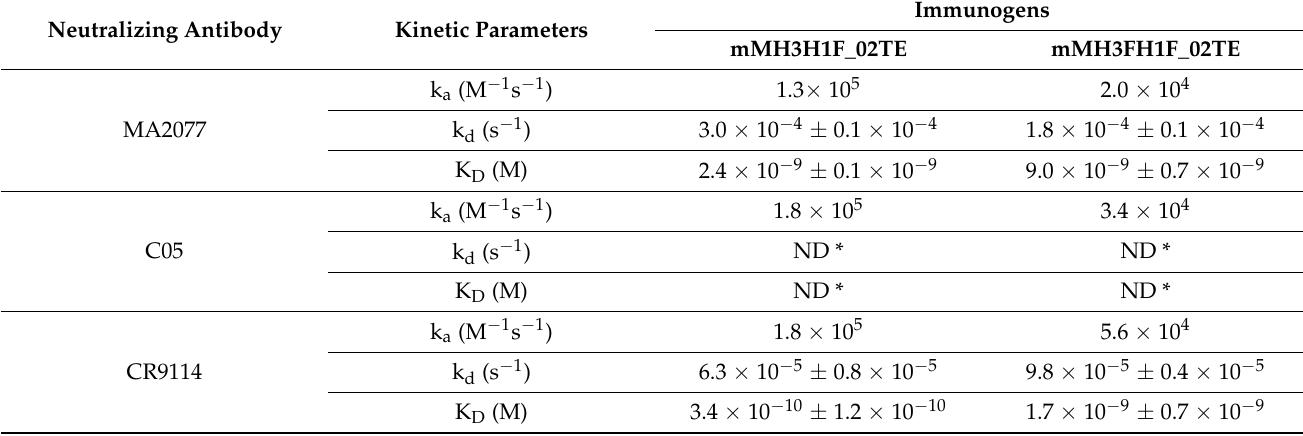
Figure 5. Hemagglutinin ectofusion immunogens bind conformation-specific broadly neutralizing antibodies. The overlays of binding kinetics monitored by SPR at different concentrations of HA ectofusion immunogens to different conformation-specific antibodies ( A and B ) MA 2077, ( C and D ) C05, and ( E and F ) CR9114 are shown. MA2077 and C05 are H1 and H3 specific HA head-directed mAbs respectively, while CR9114 is a pan-influenza specific, HA stem-directed antibody. Table 1. Hemagglutinin ectofusion immunogen binds broadly neutralizing antibodies (bnAbs) with high affinity. Kinetic parameters for conformation-specific bnAbs to HA ectofusion immunogens by SPR. * ND: No dissociation. k on error measurement values are < ± 0.01 × 10 5 .